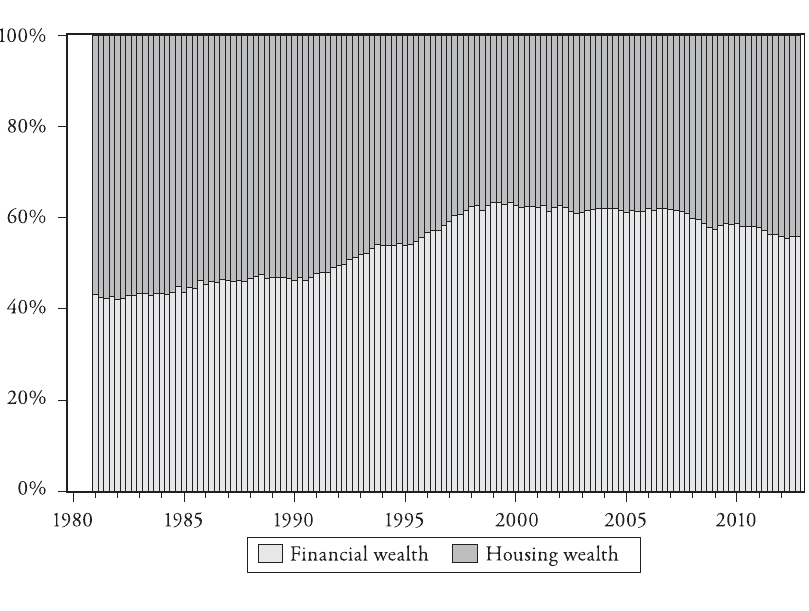
Figure 2: Decomposition of Swiss Household Wealth: Fractions of Financial and Housing